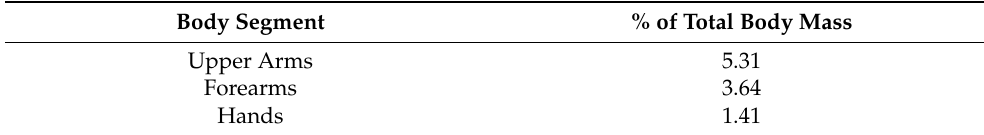
Table 4. Mass of body segments as % of total body mass